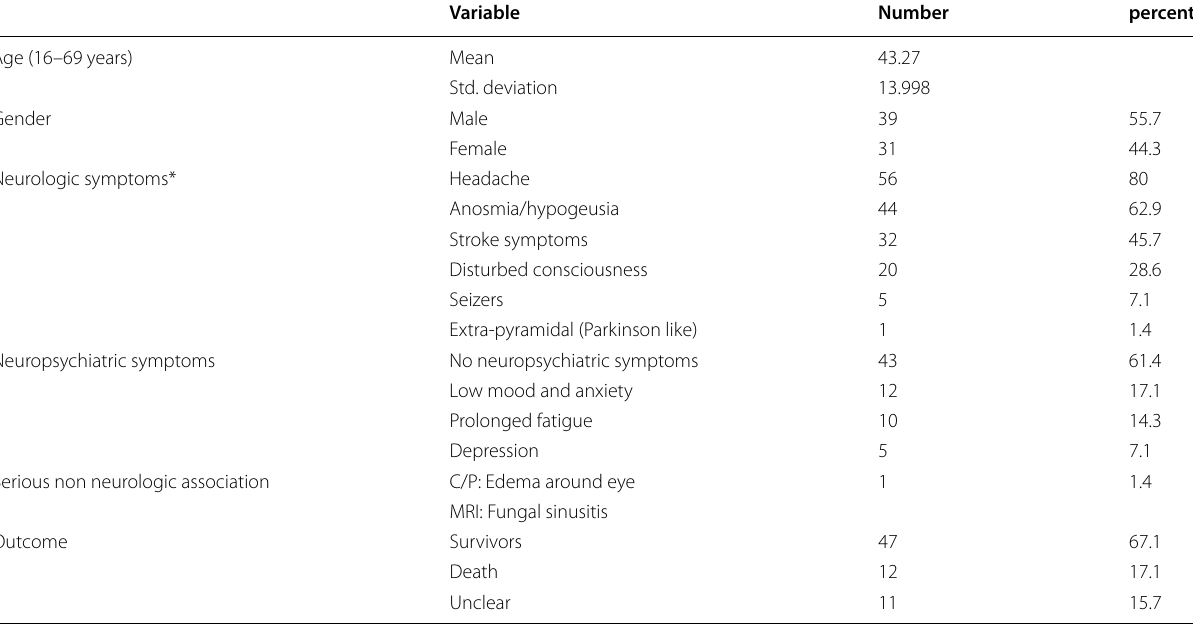
*Multiple patients had multiple symptoms